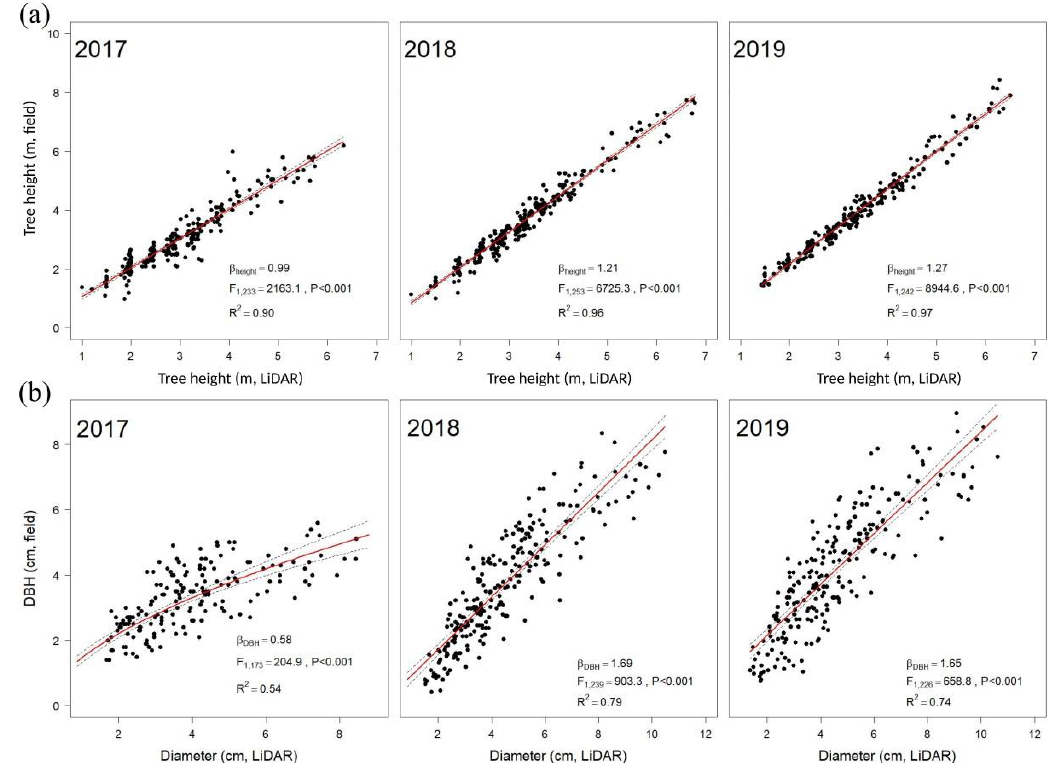
Figure 4. Validation regression plots (calculated for 240, 270, and 263 trees for 2017, 2018, and 2019, respectively) for tree height ( a ) and diameter at breast height ( b ).